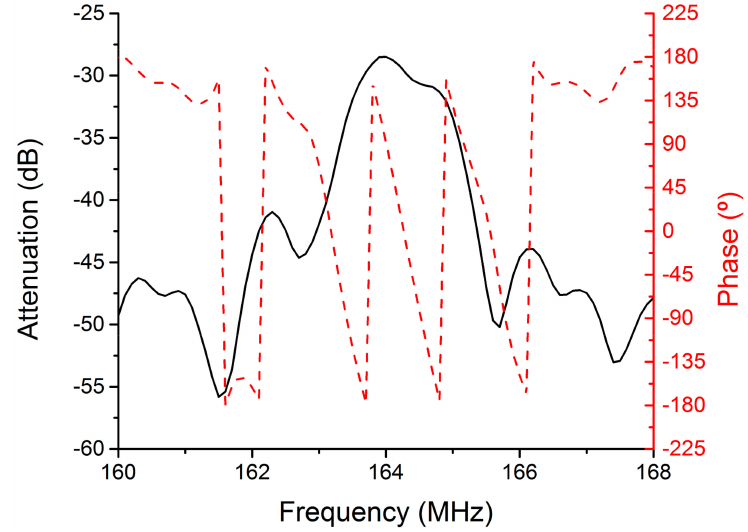
Figure 3. Amplitude and phase of transmission S 21 of a Love-wave sensor coated with an amine-functionalized iron oxide nanoparticle sensitive layer.